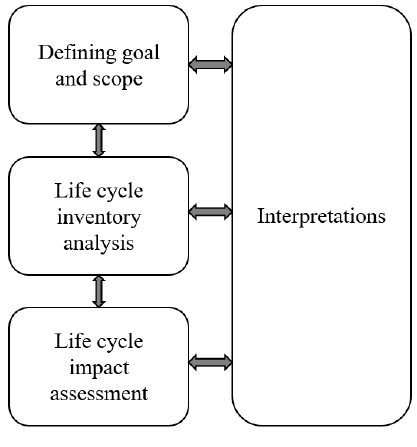
Figure 5. Framework of LCA.